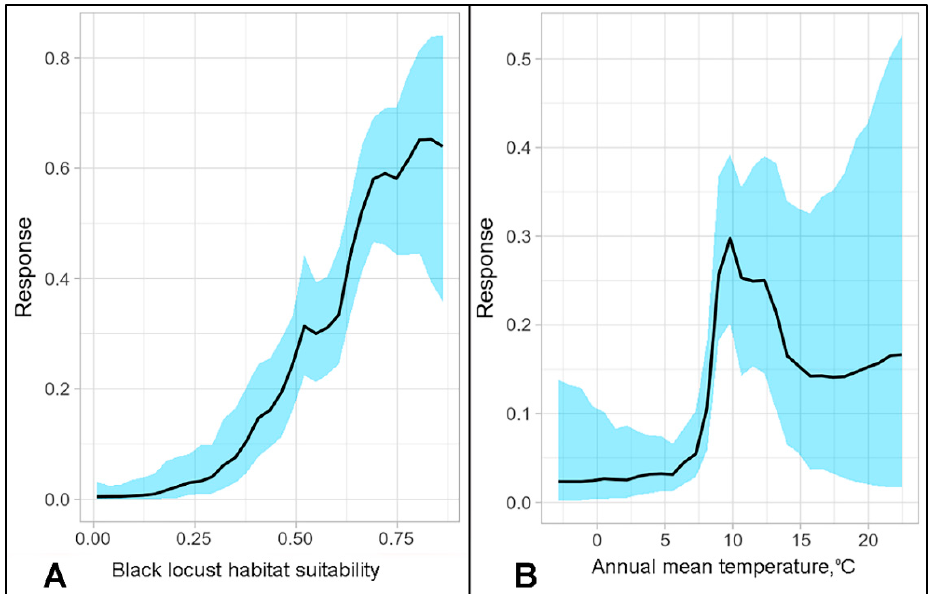
Figure 5. ( A ) Partial dependence plot for predictor: black locust habitat suitability. Response = predicted moth habitat suitability; blue area = 95% confidence interval; ( B ) partial dependence plot for predictor: annual mean temperature, °C.